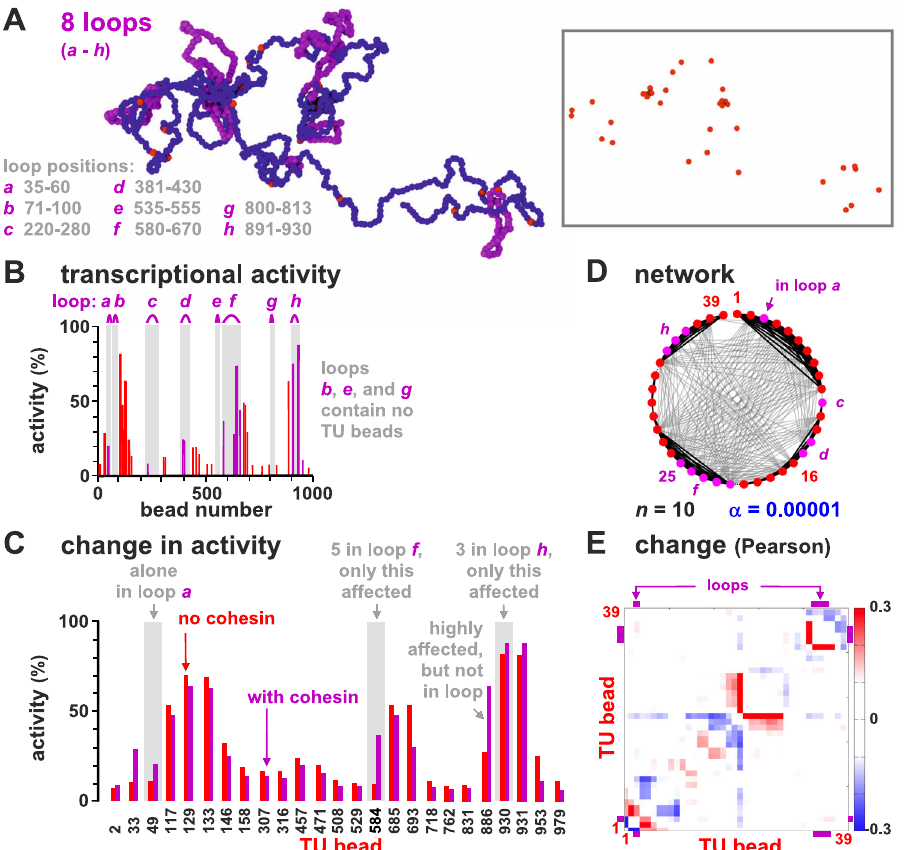
Fig. 5 Looping subtly affects transcriptional activity. Results of two sets of simulations are compared; one set as Fig. 1, in the other the chain contains eight permanent loops (to represent convergent loops stabilized by cohesin/CTCF). A Snapshot (beads within loops are magenta; TFs not shown; inset — same structure with only TUs shown). B Average transcriptional activity for each TU in the looped chain (magenta bars — values for TUs in loops; magenta arcs — loop positions). C Comparison between activity in wild type and looped con fi guration for the 25 TUs with signi fi cantly different values in the two sets ( p ≃ 0.003; two-sided Student ’ s t -test). D Regulatory network inferred from the matrix of Pearson correlations between expression levels of TUs (as Fig. 3A). E Change in Pearson correlation between TUs due to